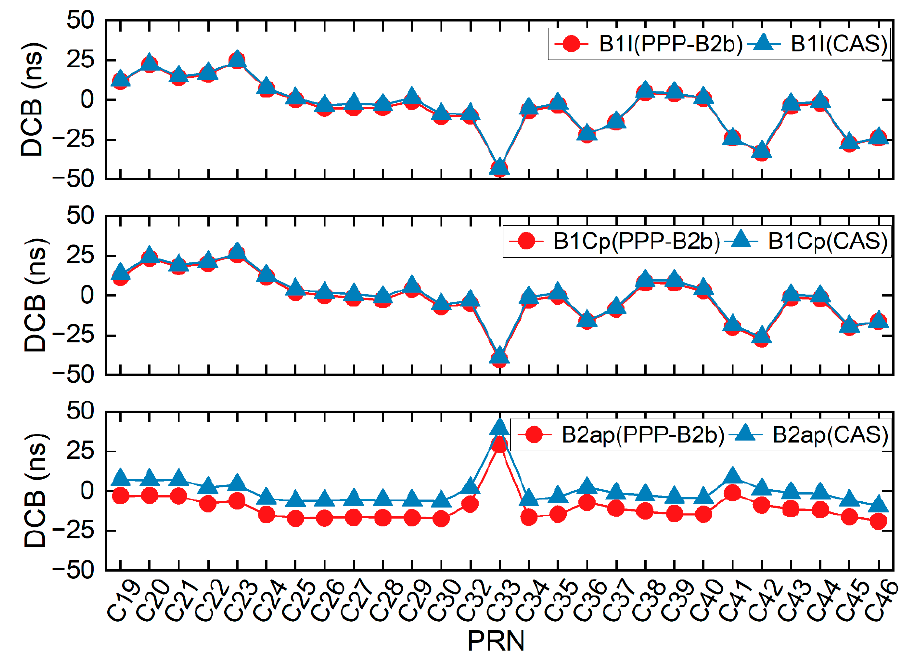
Figure 9. The DCB values of PPP-B2b and CAS for B1I-, B1Cp-, and B2ap-B3I.